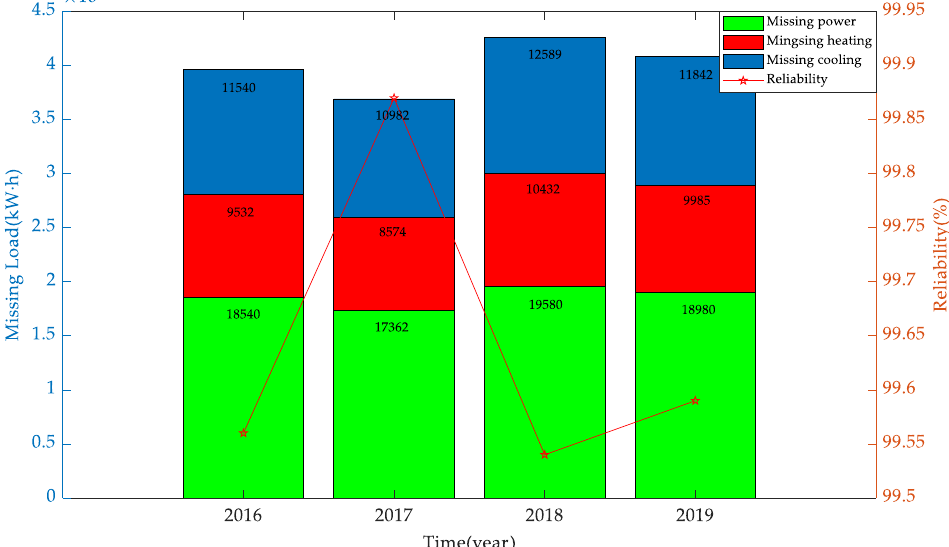
Figure 8. The missing cooling load in each year.